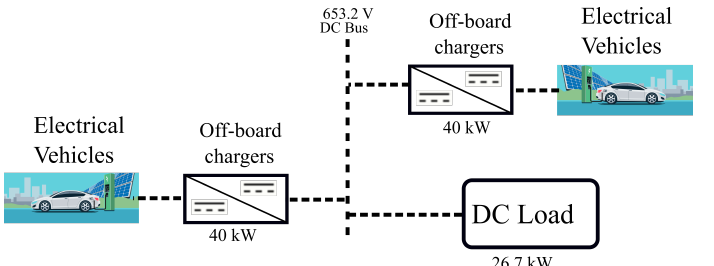
Figure 13. Illustration of V2X or the case where the vehicle supplies various loads on the same